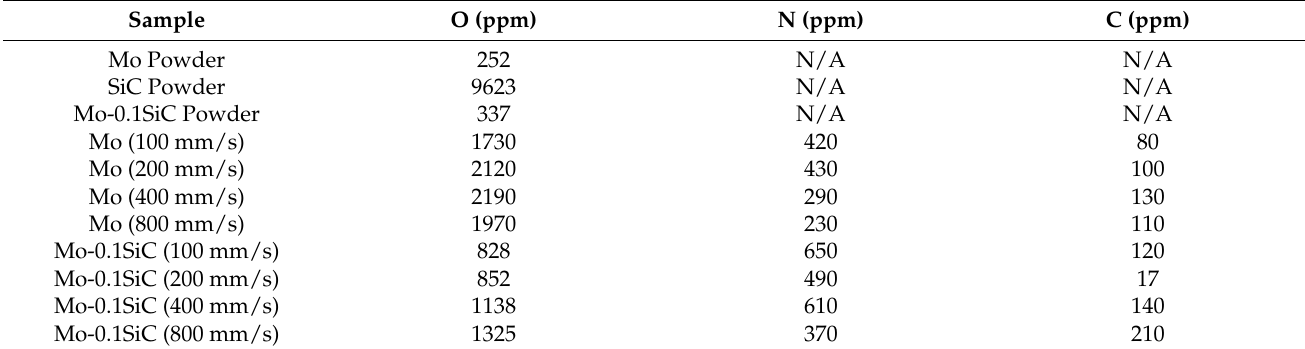
Table 2. Chemical composition of powders and LPBF specimens.